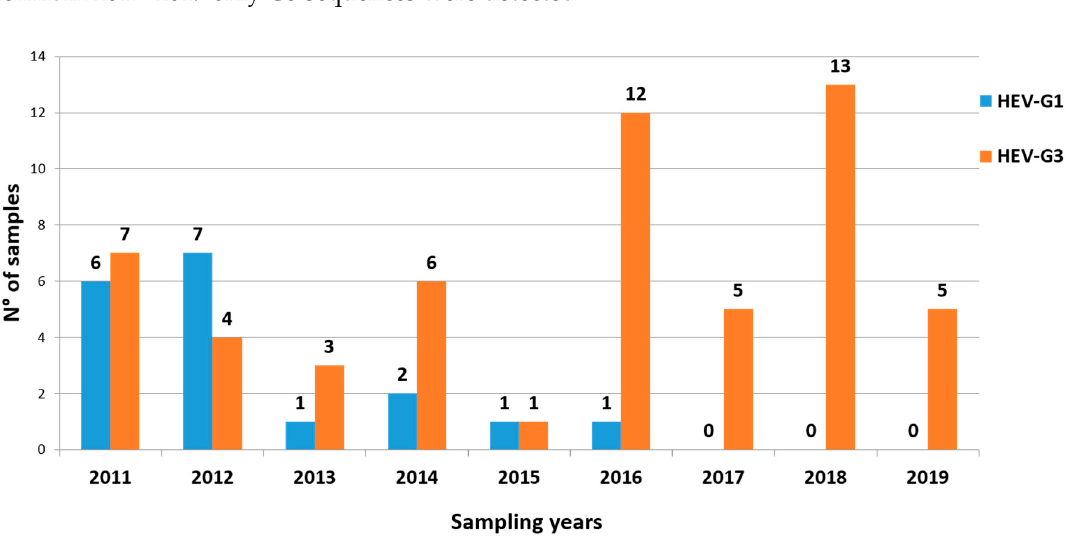
Figure 2. The distribution of positive samples (blue columns) vs total samples (orange columns) over the sampling period (2011–2019). The percentage of positive samples for each year is indicated above the absolute number.